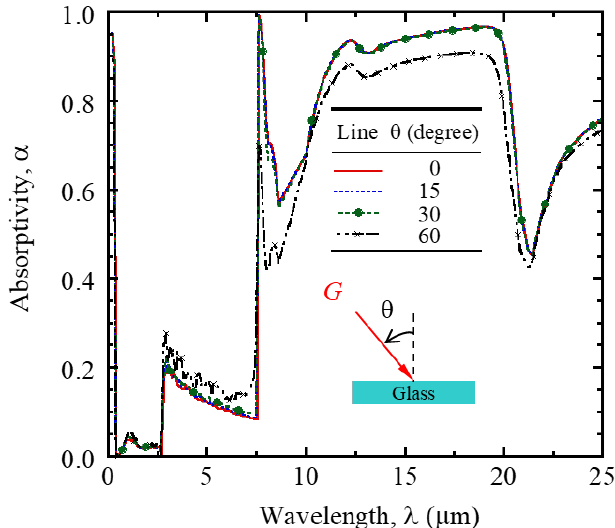
Figure 3. Absorptivity spectrum of the glass panel when the incident angle of irradiation was θ = 0°, 15°, 30°, and 60°.